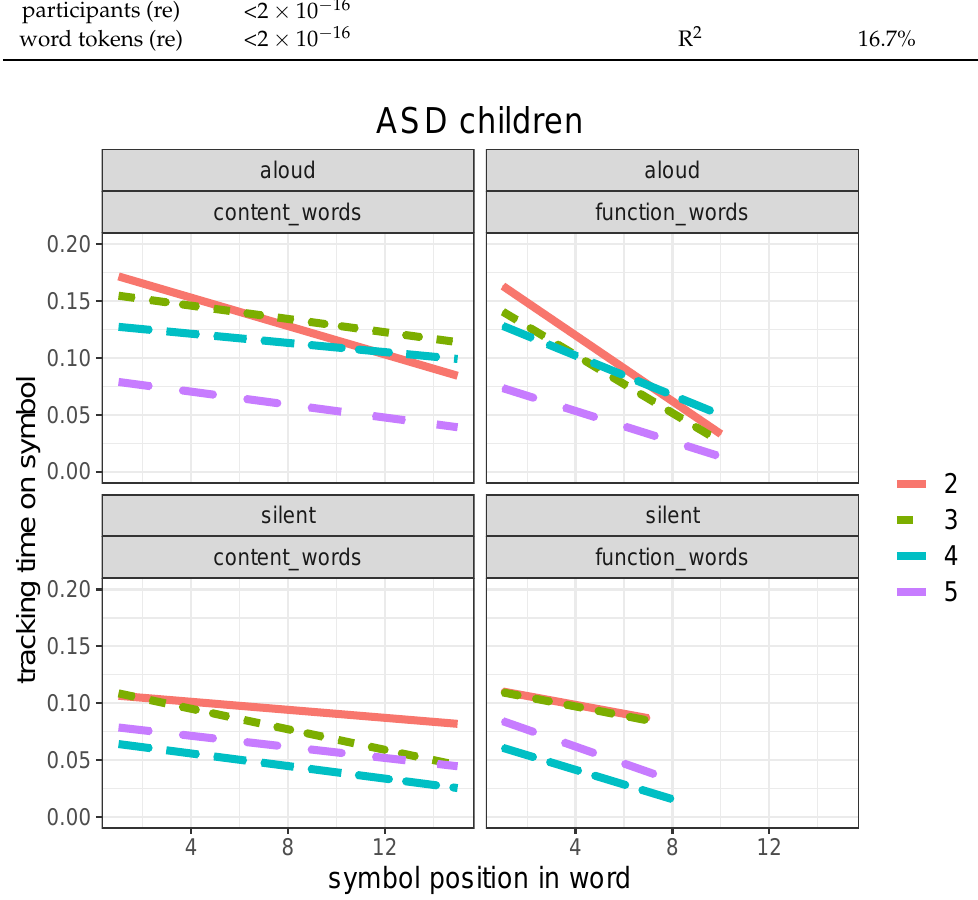
Figure 7. Linear regression plot for symbol tracking time (in seconds) as a function of their position within the word (with word onset for x = 1) for aloud ( top ) and silent ( bottom ) reading in ASD children for the four grade levels (from 2nd to 5th) for content ( left ) versus function ( right ) words (plot obtained with the ggplot2 package, function lm